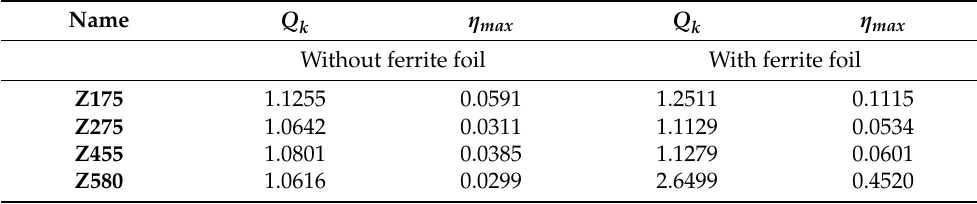
Table 9. Results for transmission quality Q k and maximum efficiency η max of test series